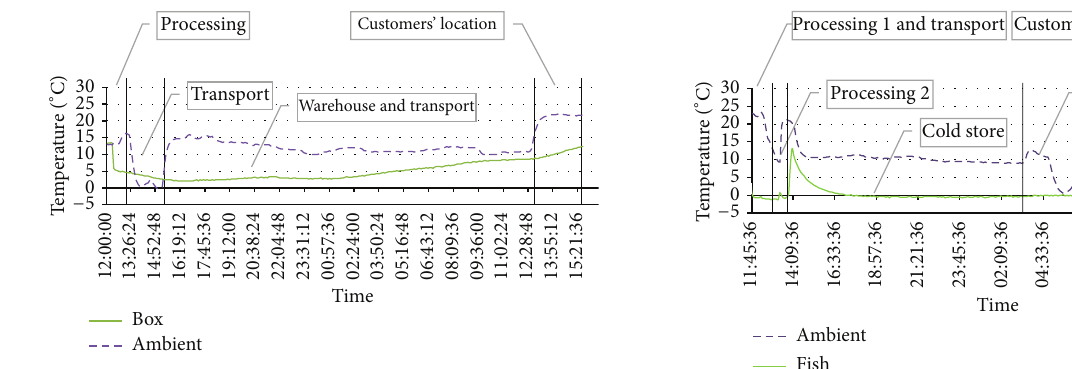
Figure 11: Temperature graph (Seˇca, 23.4.2012—Treviso, 24.4.2012).